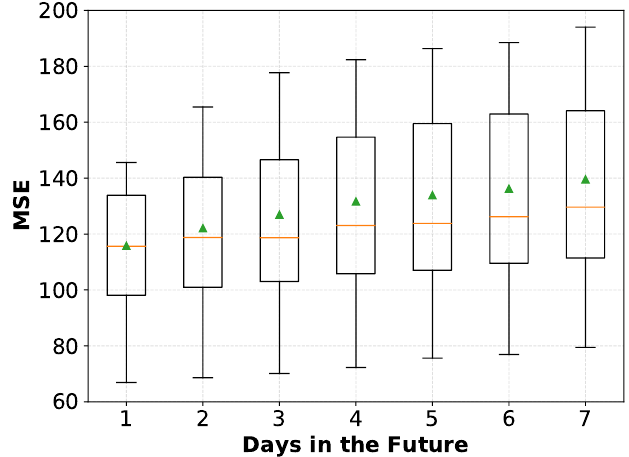
Figure 21. MSE performance of the three-layer ANN model in the entire year of 2016 for the prediction of several days in the